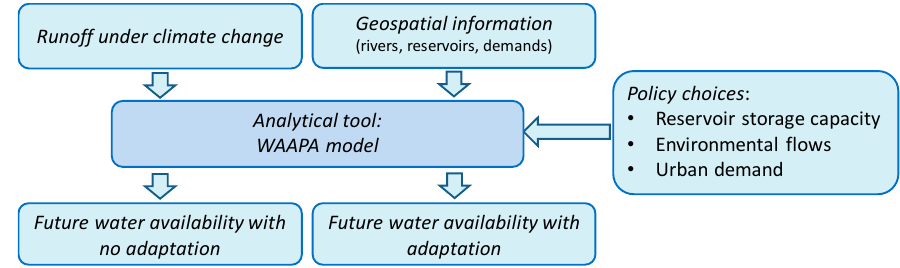
Figure 4. Approach to evaluate scenarios of future water availability for agriculture.